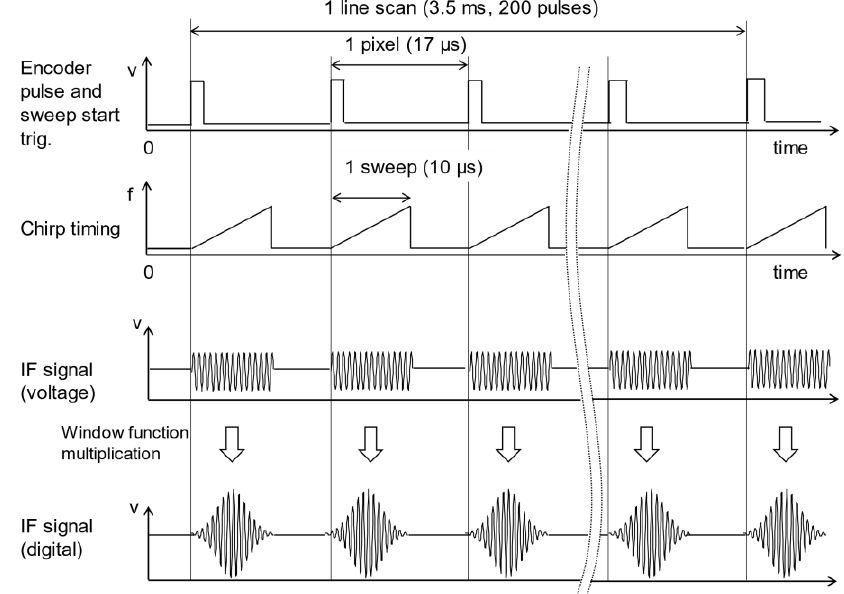
Figure 10. Timing chart during a vertical scanning and data processing.